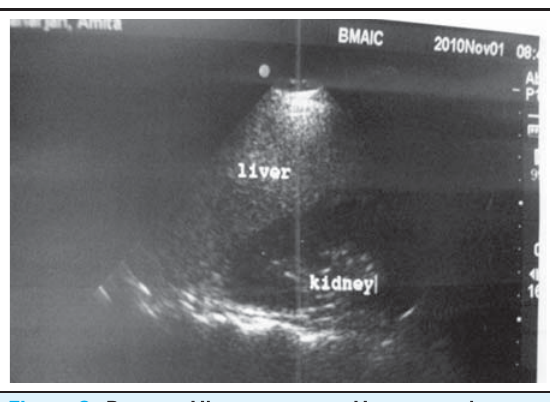
Figure 3. Post-op Ultrasonogram, Hepatorenal